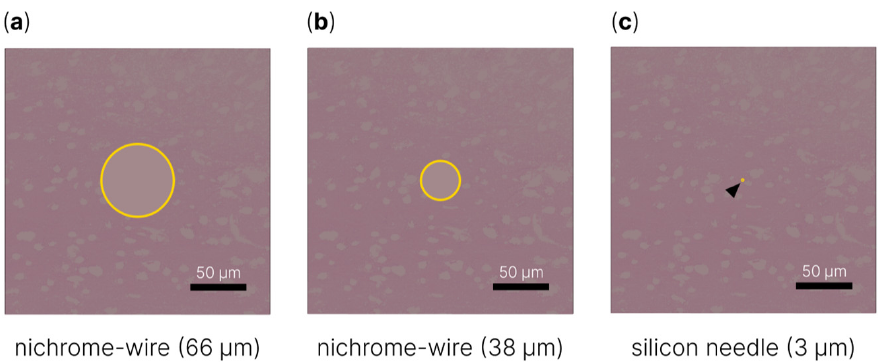
Figure 2. Schematic representation of tissue damage area after implantation of ( a ) 66 µm diameter nichrome wire, ( b ) 38 µm diameter nichrome wire and ( c ) 3 µm diameter silicon needle [99]. nichrome wire, ( b ) 38 µ m diameter nichrome wire and ( c ) 3 µ m diameter silicon needle